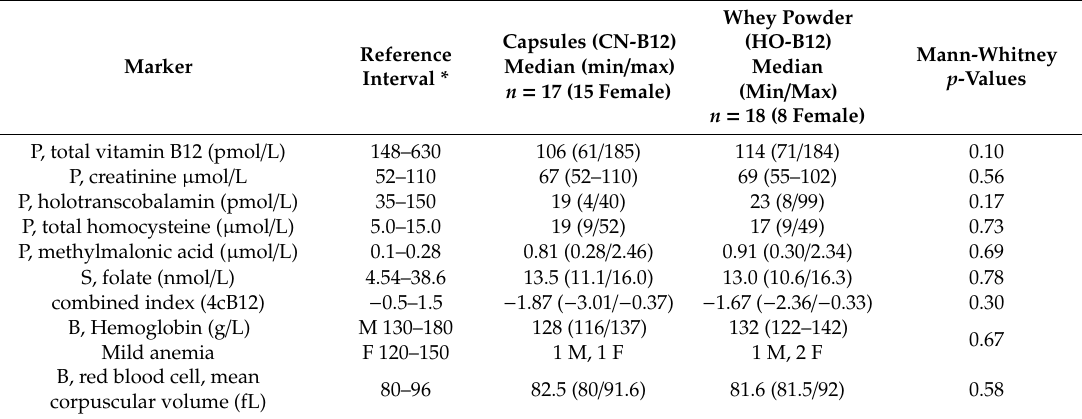
Table 1. Concentrations of biomarkers at baseline for participants receiving capsules or whey powder supplements.